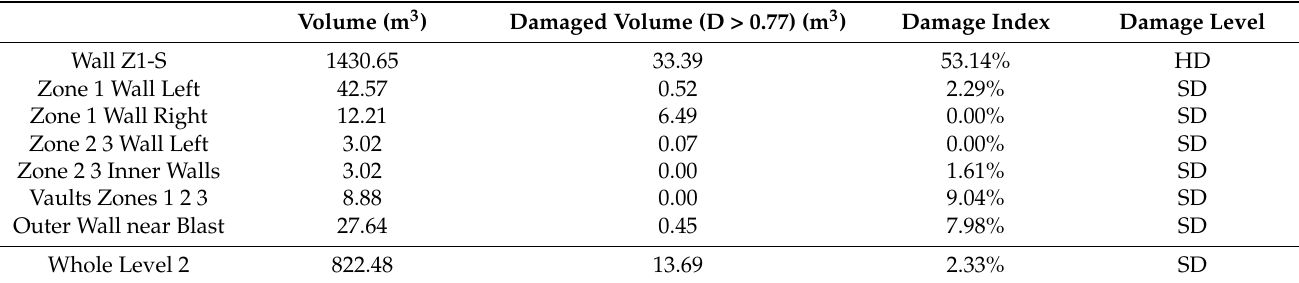
Table 5. Total volume, volume of damaged elements, damage index, and damage level for different structural